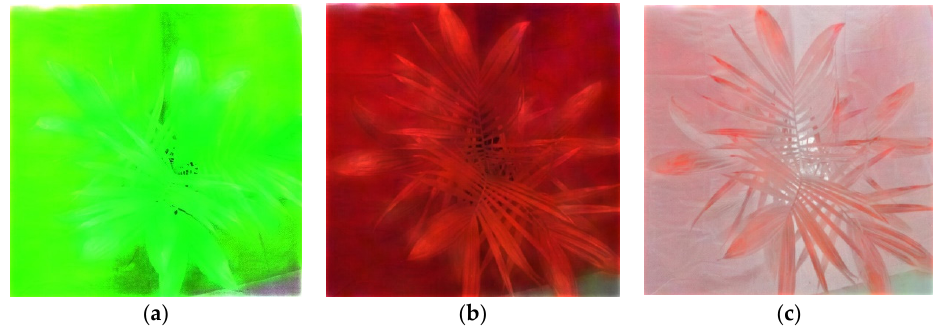
Figure 11. Comparison of images generated using ( a ) wavelengths 766 nm, 762 nm and 770 nm and ( b ) images generated using wavelengths 750 nm, 554 nm and 466 nm without the grayscale layer added in the alpha channel and ( c ) with grayscale layer added in the alpha channel.